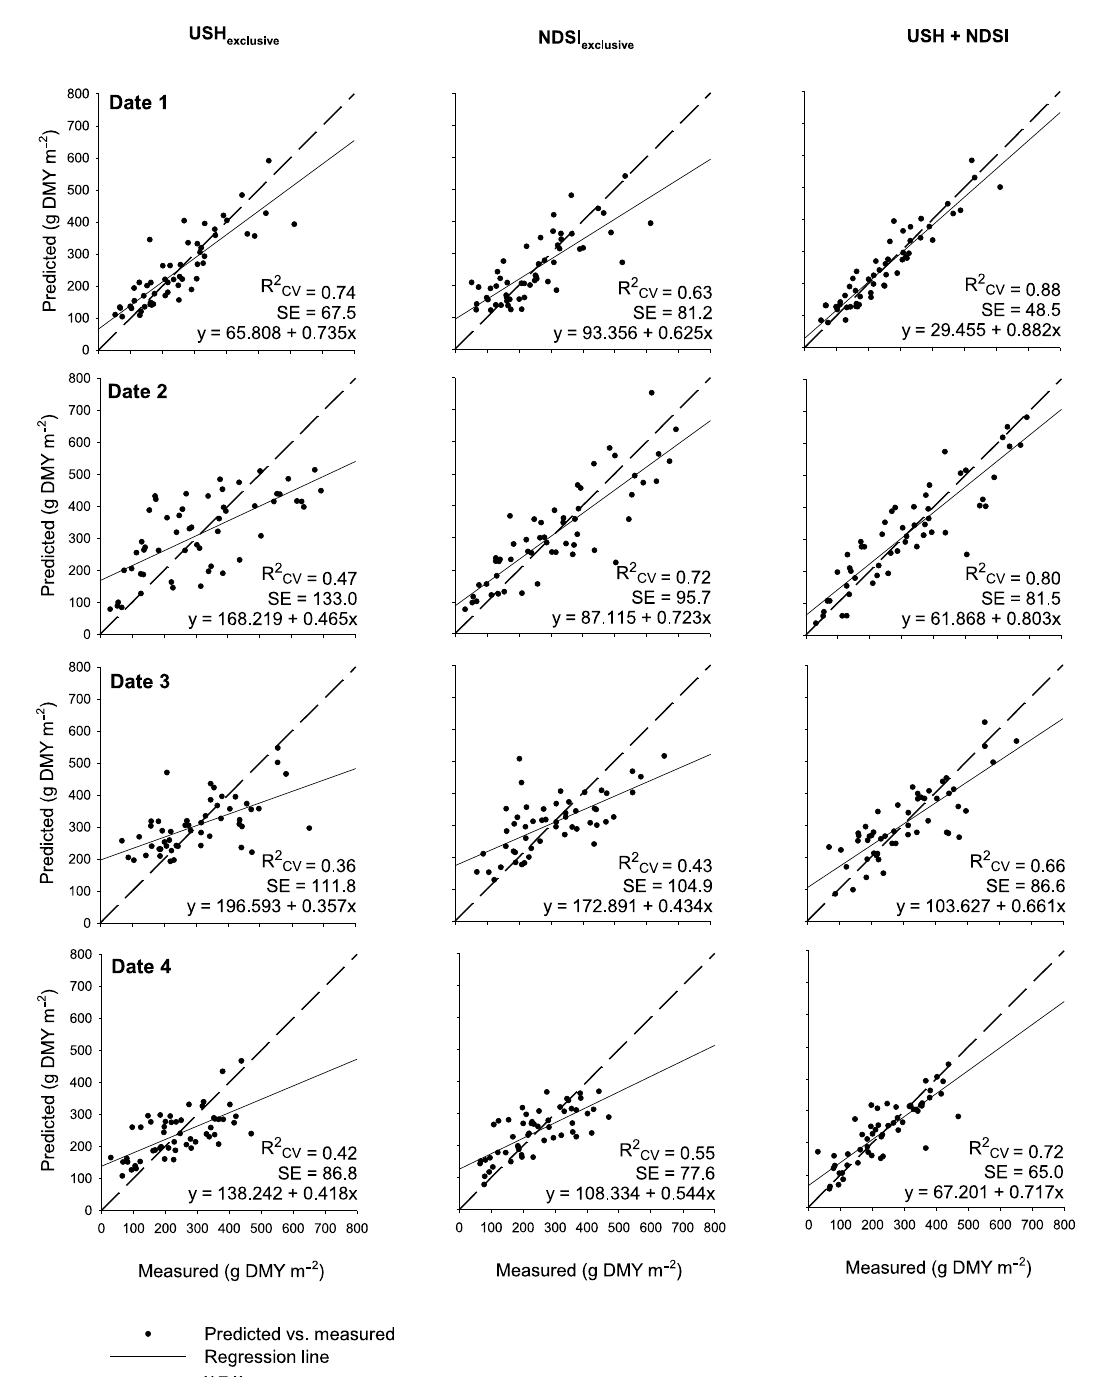
Figure 4. Plots of fit between measured and predicted dry matter yield (DMY) for exclusive use of ultrasonic sward height (USH exclusive ) and the best fit normalized difference spectral index (NDSI exclusive ) as well as a combination of USH and NDSI (USH + NDSI) applied in date-specific swards.